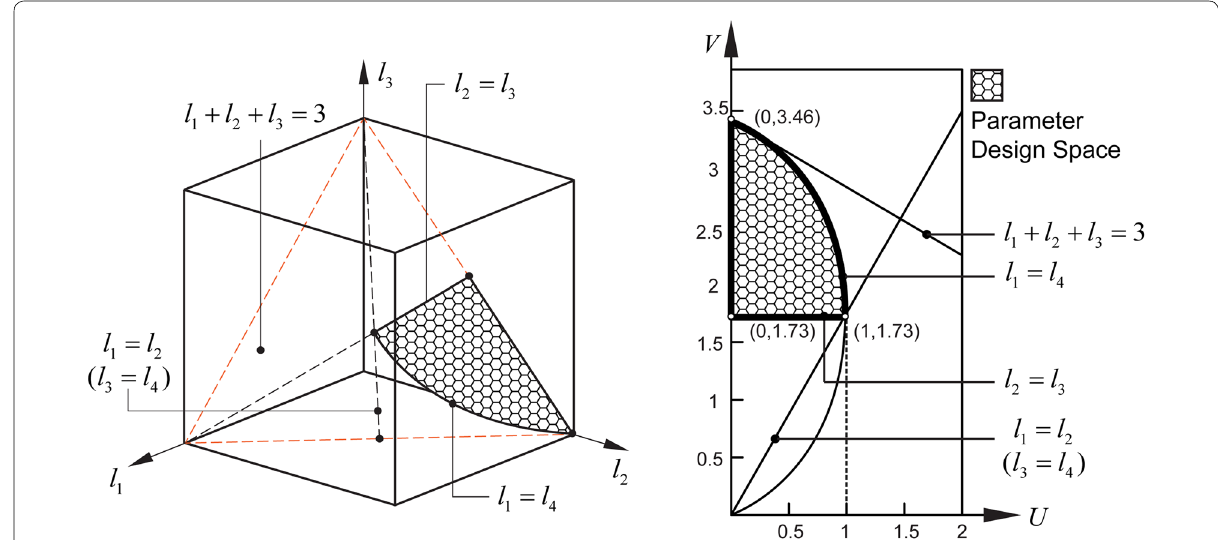
Figure 6 Parameter design space [50,